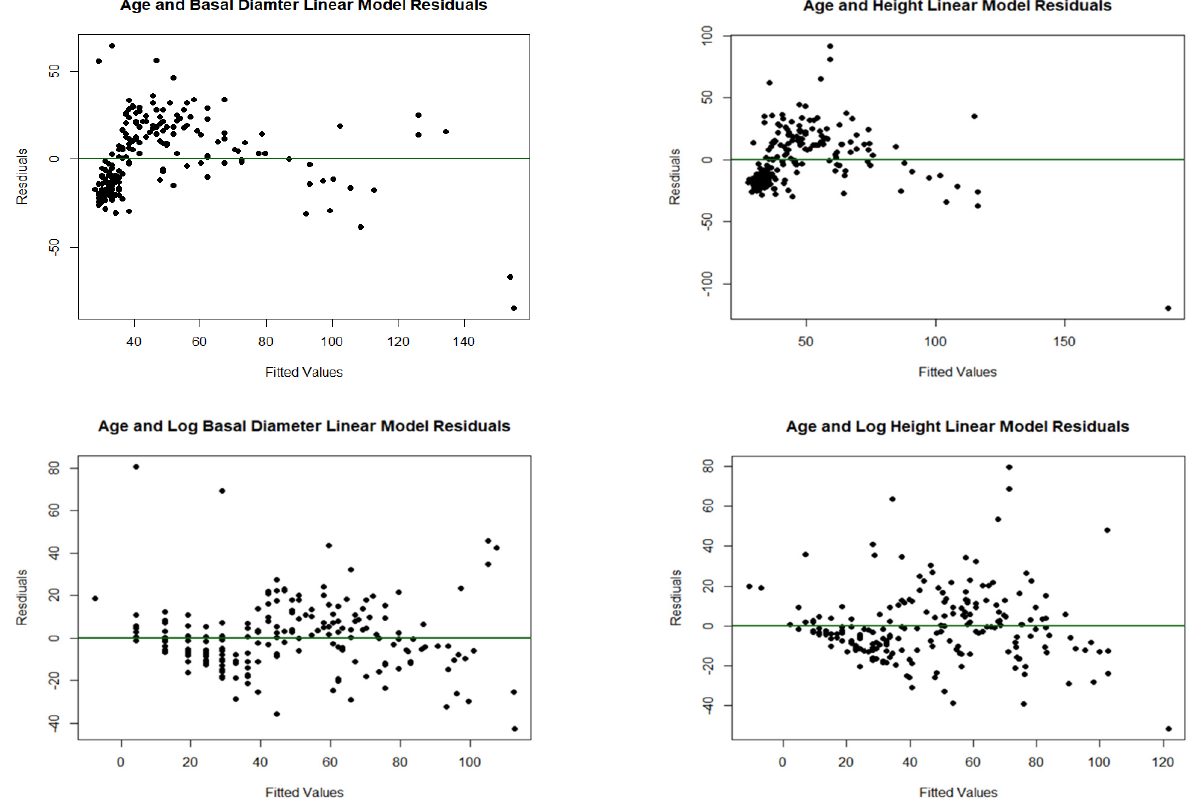
Figure A6. Shows the difference between the transformed and untransformed residuals for linear models built to show the relationships between age and growth of trees.